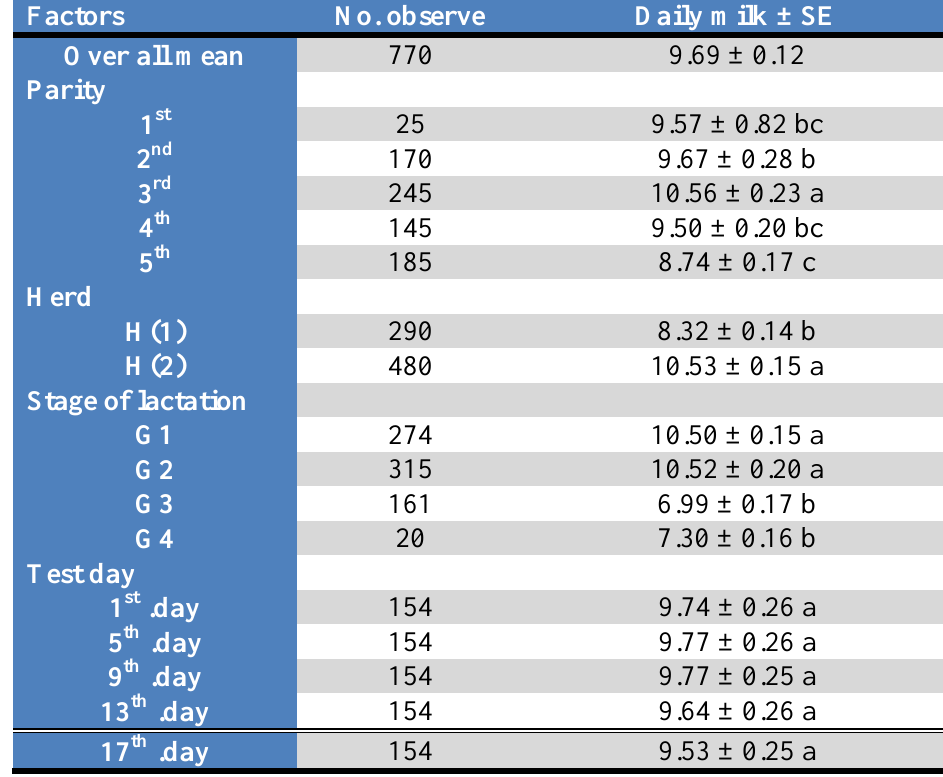
Table 2. Study factors affecting on daily buffaloes milk yield (kg) (mean ±